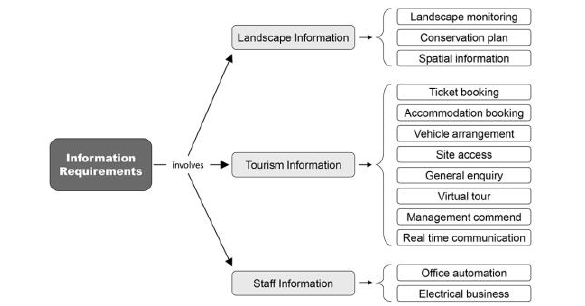
Figure 2. Information requirements of pilot Scenic Areas in China